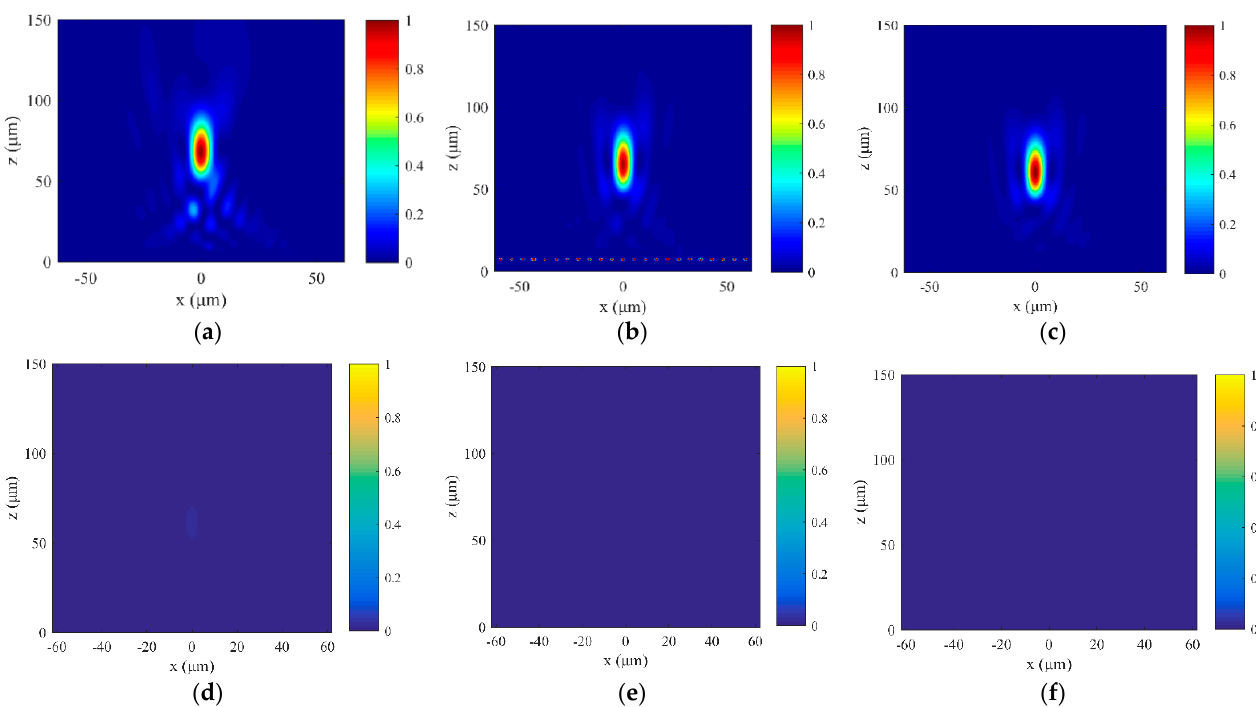
Figure 4. The amplitude profiles for amorphous-GST at the incident wavelengths of ( a ) 10 μ m ( b ) 10.5 μ m and ( c ) 11 μ m with obvious focusing; after GST phase change into the crystalline state, the amplitude profiles for crystalline-GST at the wavelengths of ( d ) 10 μ m, ( e ) 10.5 μ m, and ( f ) 11 μ m indicate no focusing.